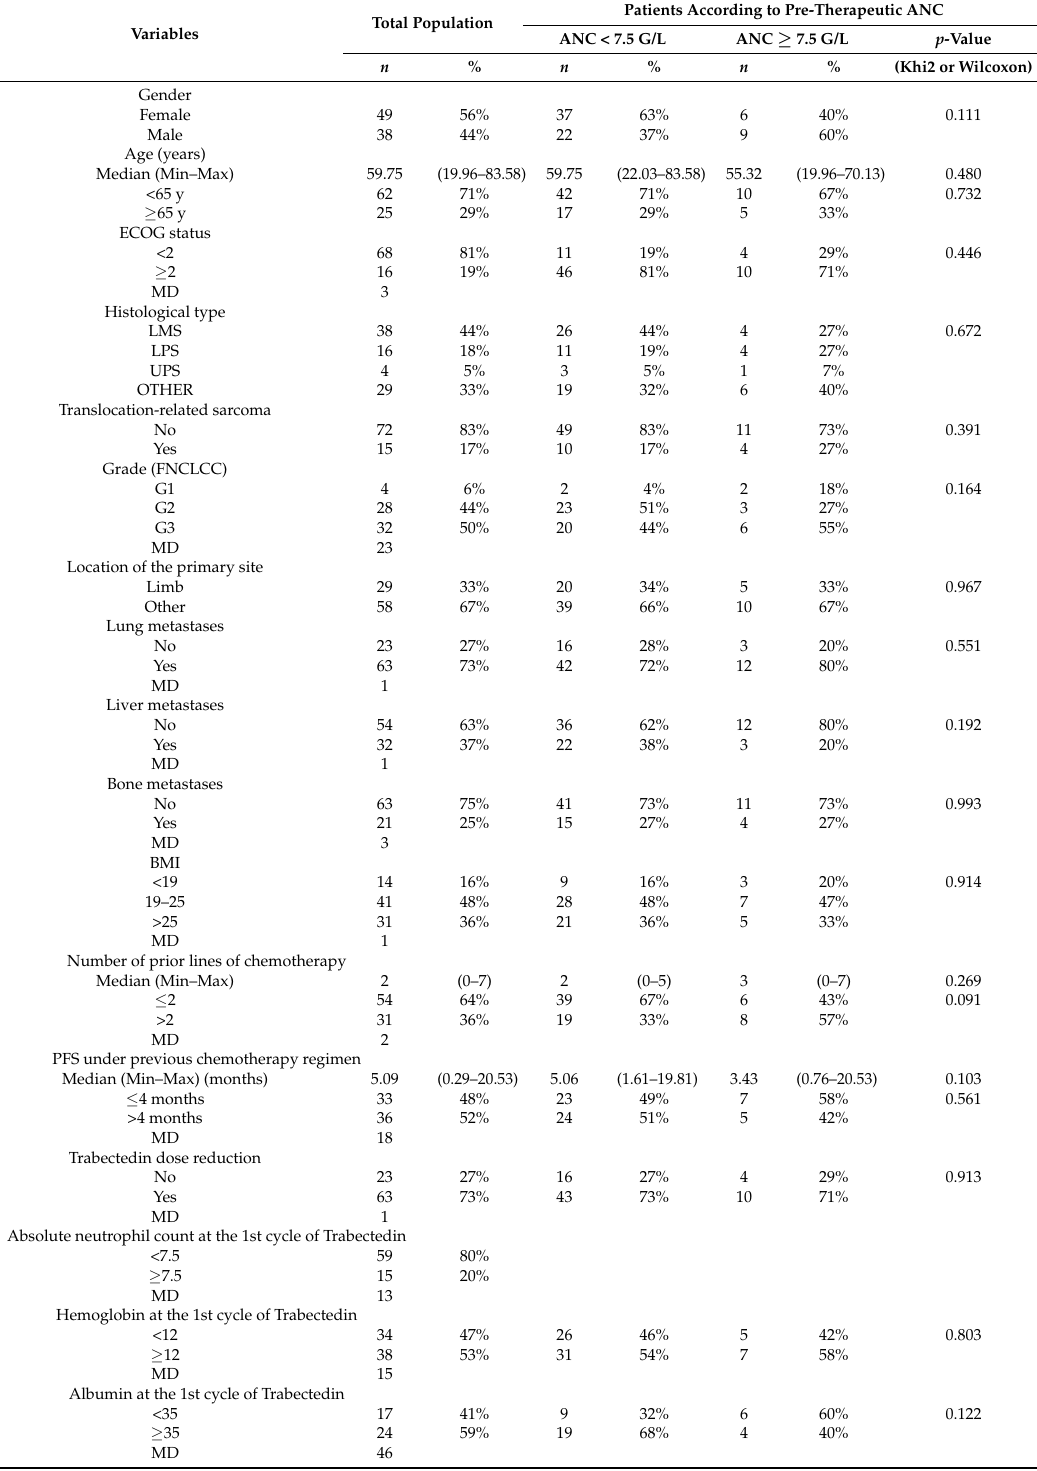
Table 1. Patient and tumor characteristics. Percentages are calculated in relation to the number of available